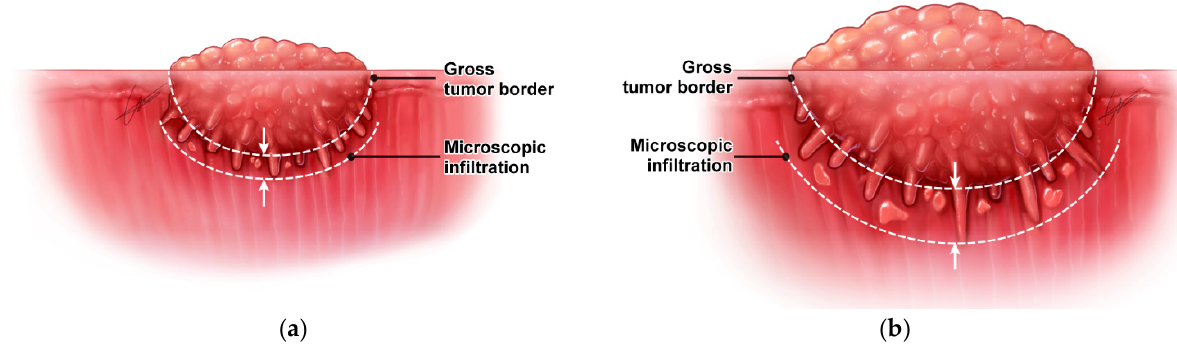
Figure 3. Microscopic infiltration depending on the gross tumor dimension. ( a ) A limited microscopic infiltration in a small-sized primary tumor; ( b ) an increased degree of microscopic infiltration in a large primary tumor.